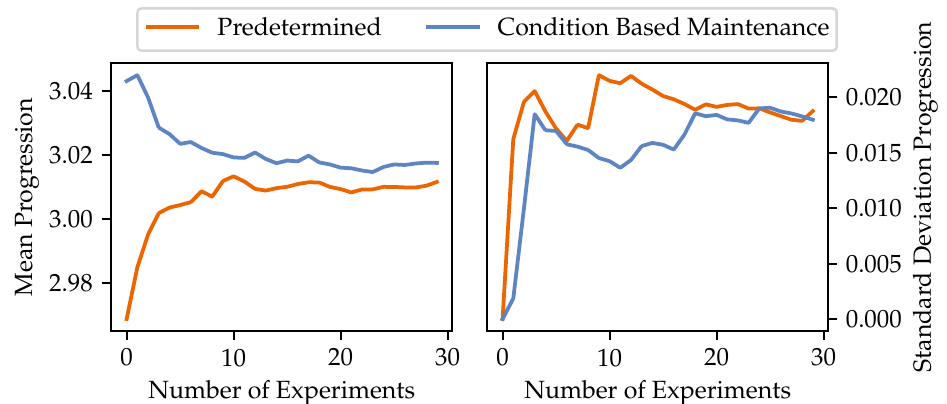
Figure 10. Progression of mean and standard deviation over the number of simulation runs for M deployment .